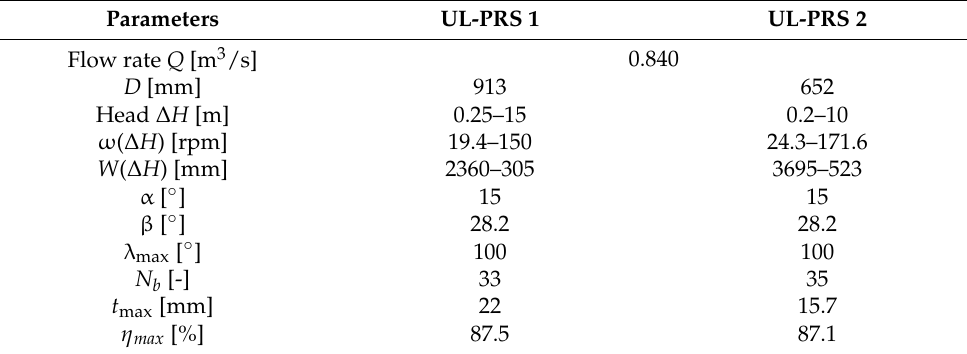
Table 2. UL-PRS 1 and UL-PRS 2